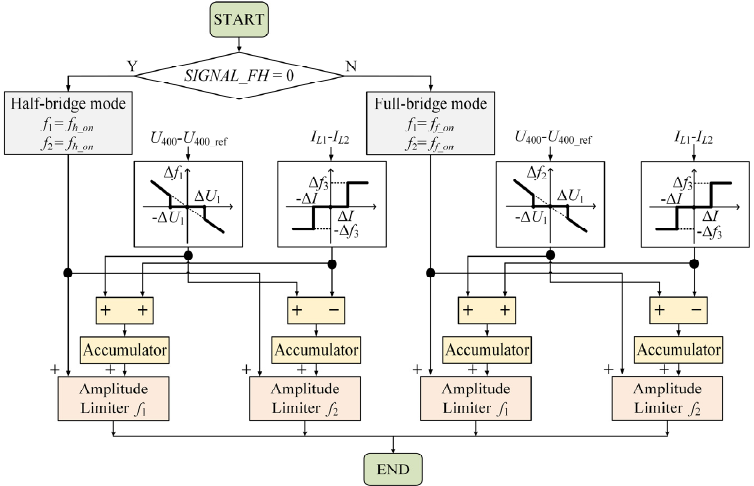
Figure 10. LLC control scheme in on-line mode.